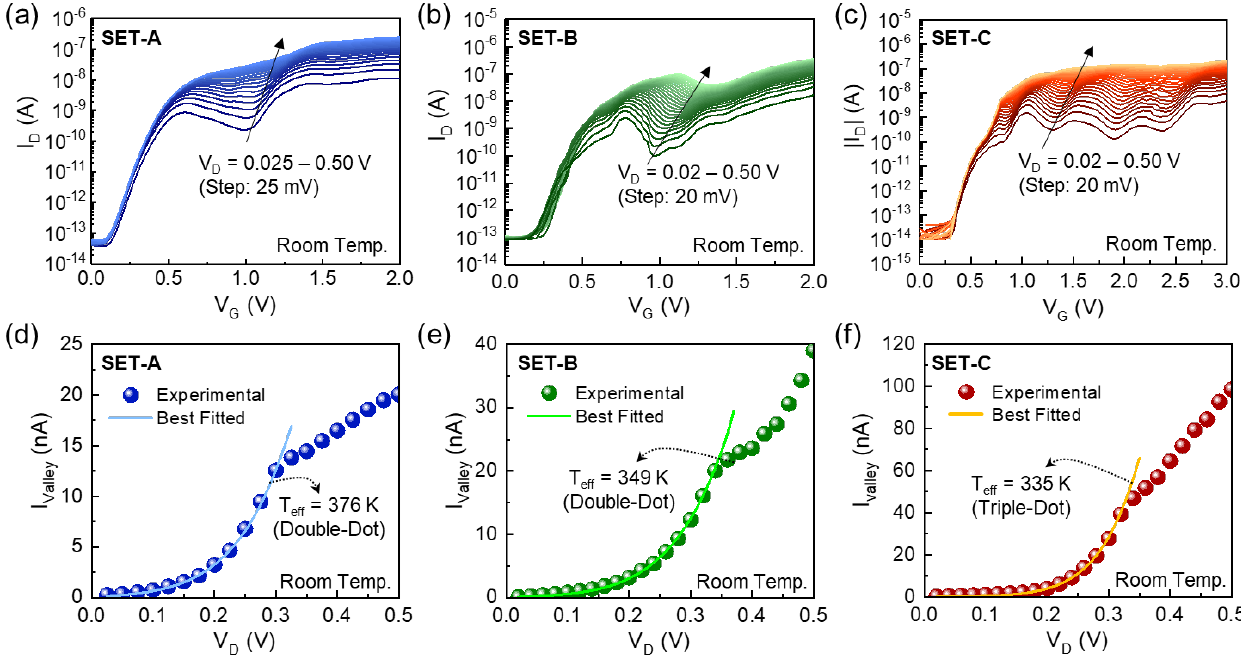
Figure 3. Evolution of the CBO peaks at the positive V D region (i.e., I D – V G curves at V D = 0.02 – 0.5 V) for ( a ) SET-A, ( b ) SET-B, and ( c ) SET-C; and the I valley as a function of V D for ( d ) SET-A, ( e ) SET-B, and ( f ) SET-C.